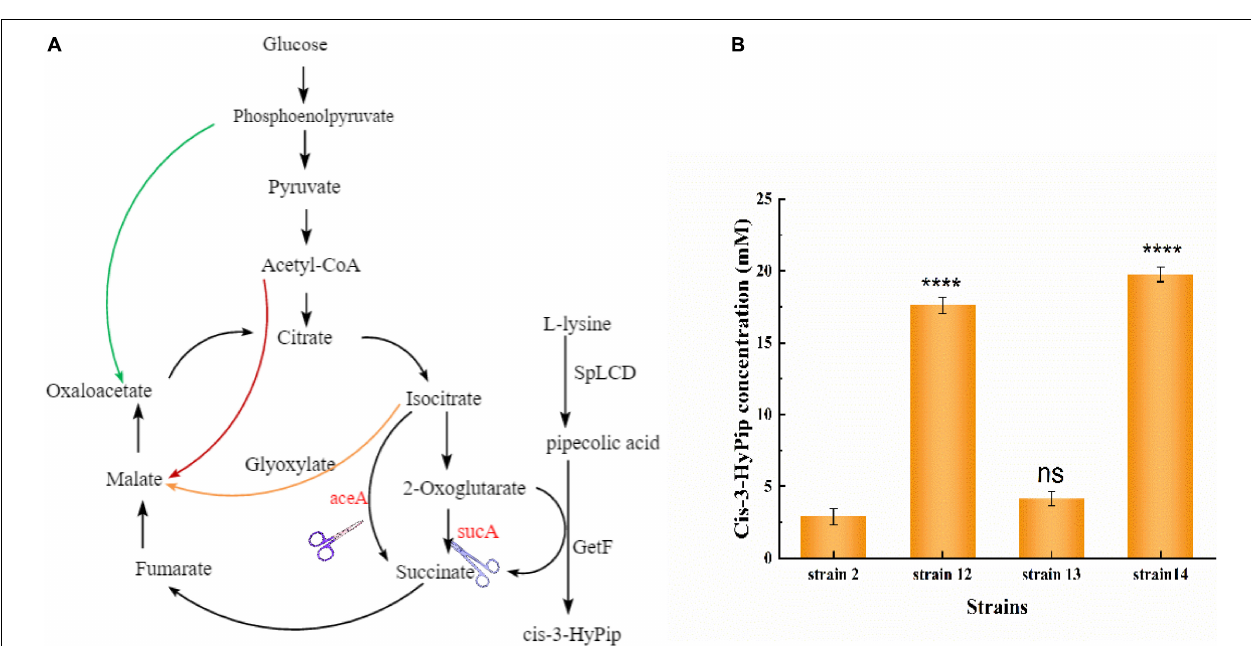
FIGURE 3 | Polymerase chain reaction analysis of mutant strains. (A) Primers (F3/R3) were designed to target both ends of the sucA for the PCR detection of positive strains. The 1761-bp PCR-amplified fragment indicates that the sucA was knocked out, while the presence of a 4,563-bp fragment indicates that this gene was not knocked out. Lane 1: E. coli BL21(DE3) (cid:49) sucA ; lane 2: E. coli BL21(DE3). (B) Primers (F3/R3) were designed to target both ends of the aceA for the PCR detection of positive strains. The 1586-bp PCR-amplified fragment indicates that the aceA was knocked out, whereas the presence of a 2,891-bp fragment indicates that this gene was not knocked out. Lane 3: E. coli BL21(DE3) (cid:49) aceA ; Lane 4: E. coli BL21(DE3).